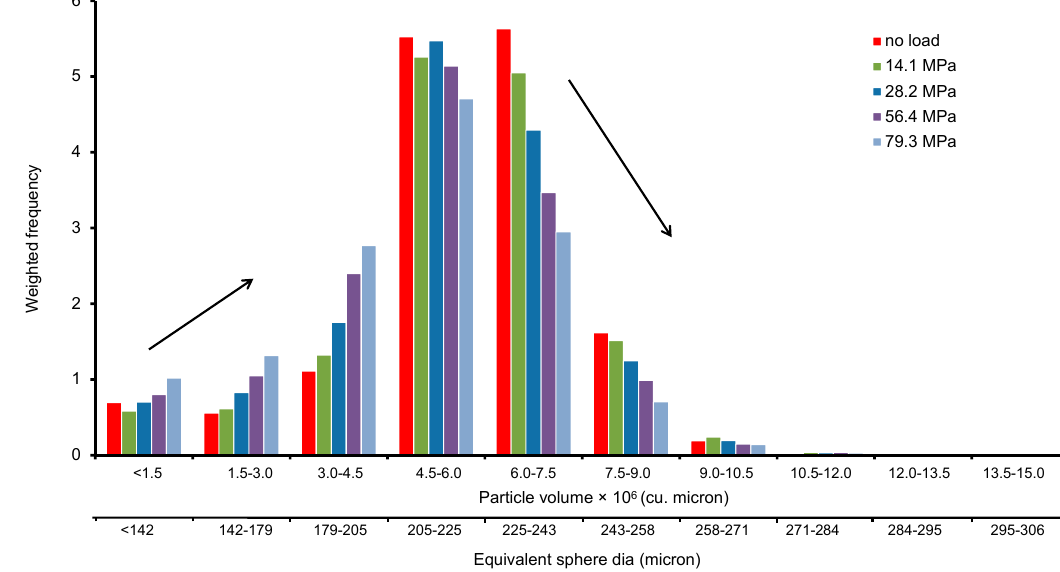
Figure 12. Particle size frequency distribution.